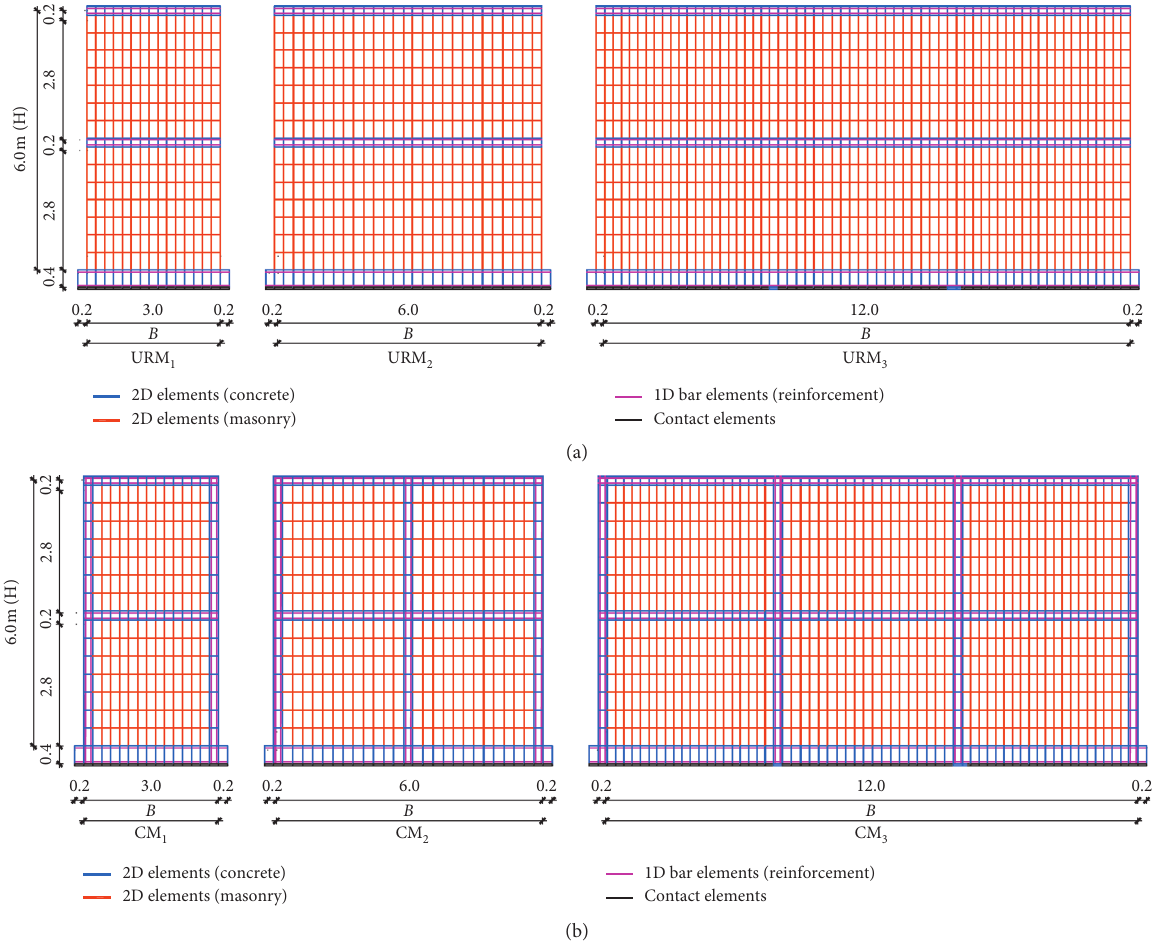
Figure 8: Finite element discretization of the walls: (a) unreinforced masonry walls; (b) confined masonry walls.